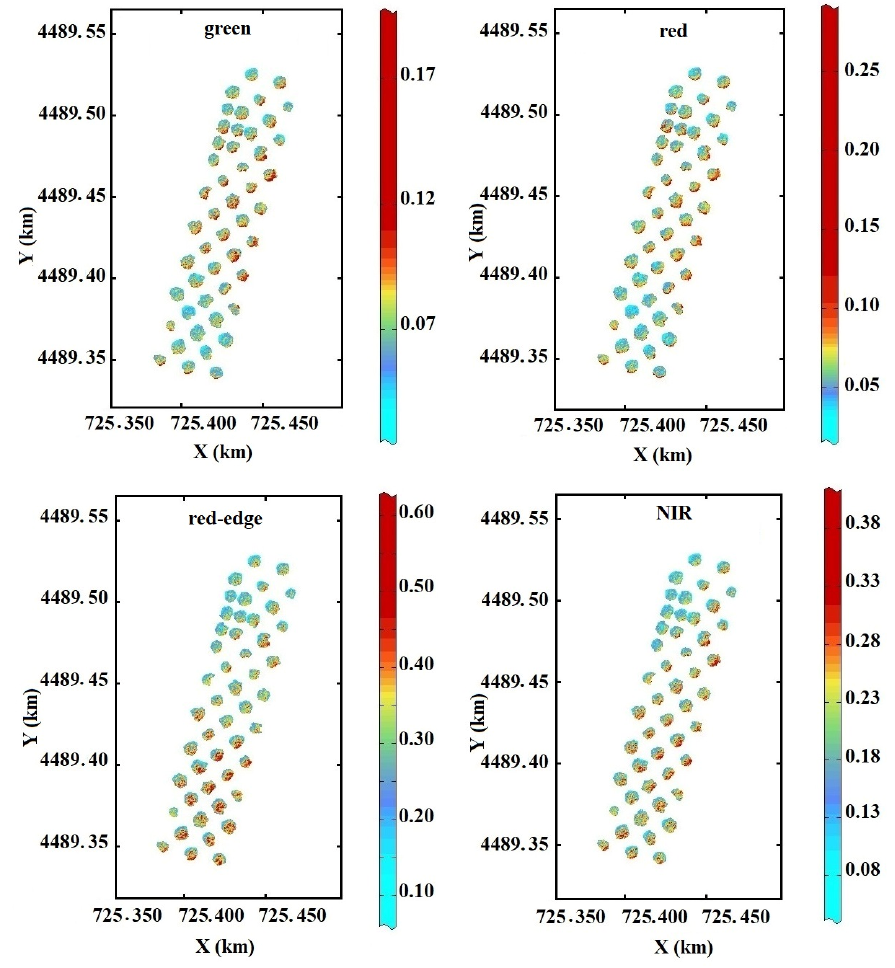
Figure 3. Multi-band reflectance images of the study site. The color legend uses 10 isofrequency classes.